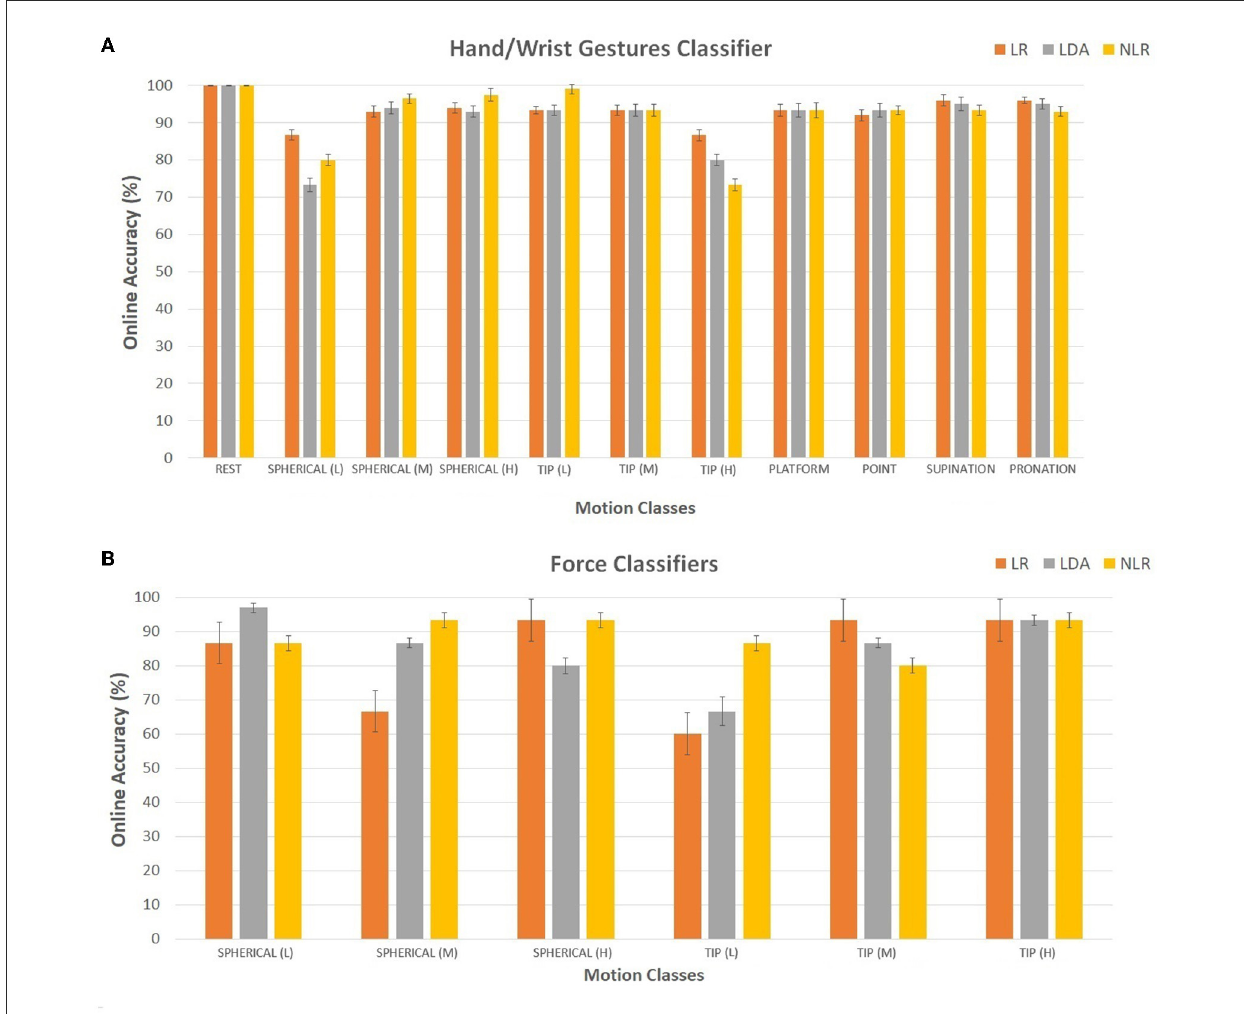
FIGURE5 (A, B) Online accuracy calculated for 15 transradial amputees using the LR (in orange), LDA (in gray), and NLR (in yellow) “hand/wrist gestures classifier” (A) and the LR (in orange), LDA (in gray), and NLR (in yellow) force classifiers (B) : the “spherical force classifier” and the “tip force classifier” for the spherical and tip grasp,